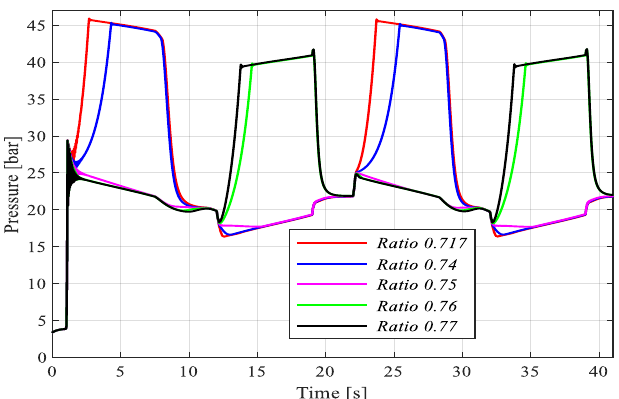
Figure 13. Pressure in the piston head chamber for different displacement ratios. Cracking pressure = 30 bar.